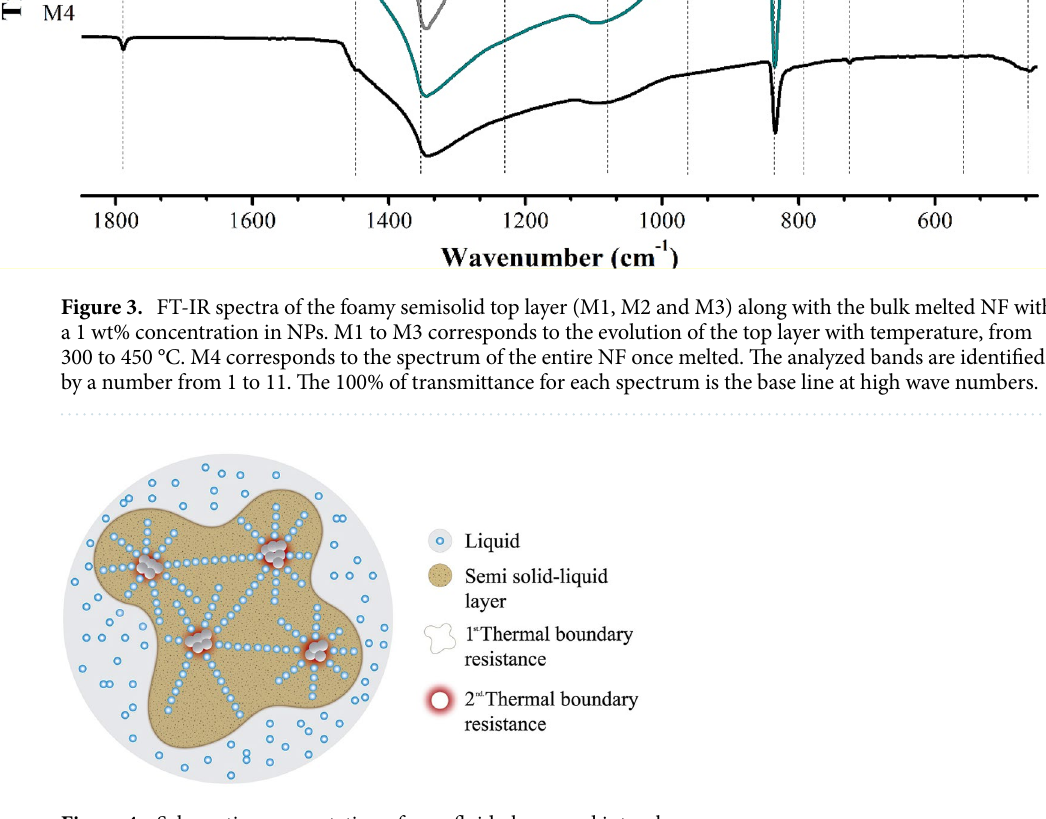
Figure 4. Schematic representation of nanofluid phases and